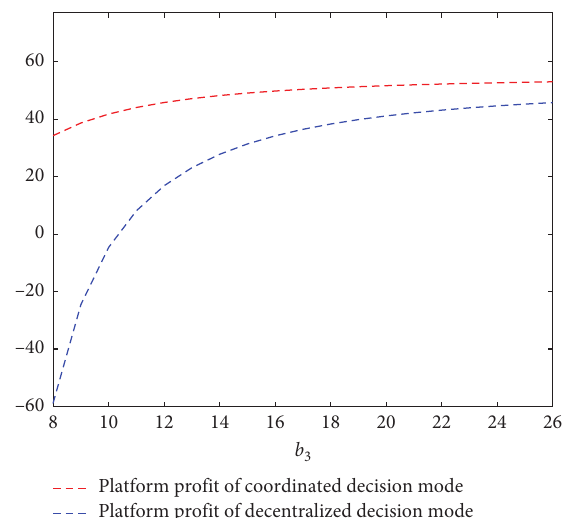
Figure 6: Influence of b 3 on the profit of platform service